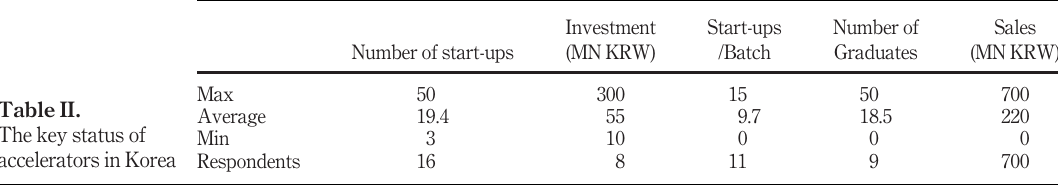
Table II. The key status of accelerators in